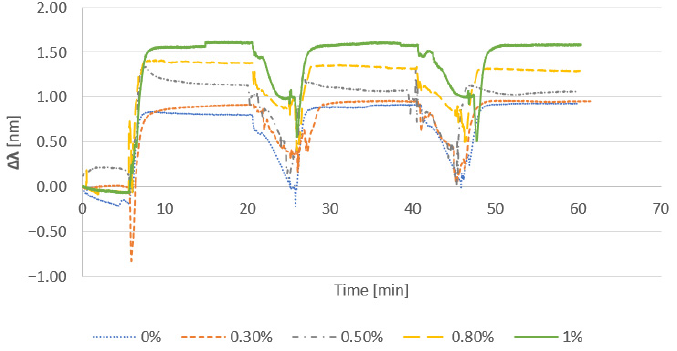
Figure 1. NPS signal as a function of time for samples formulated with SLES/CAPB 12 wt. % and different levels of the cationic polymer at room temperature and pH ~7. NPS, Nano Plasmonic Sensing.